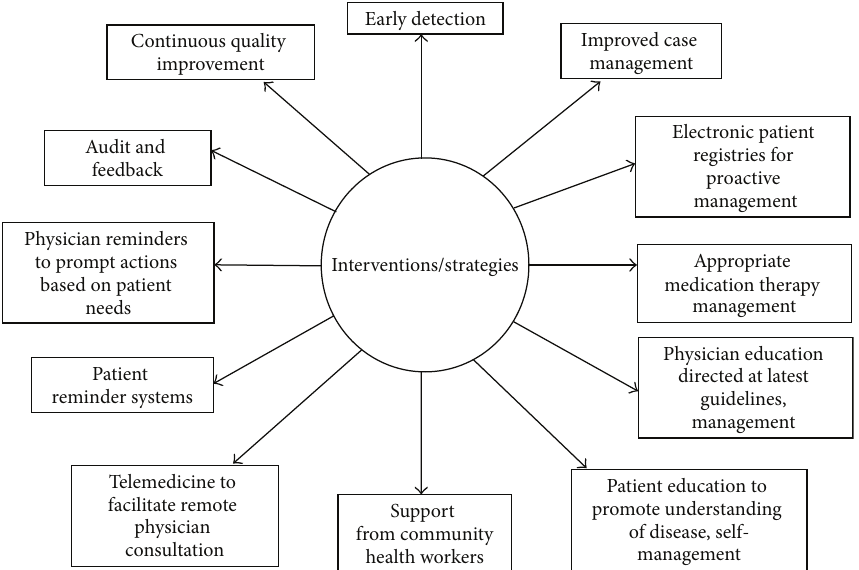
Figure 3: Interventions/strategies to improve health care for chronic